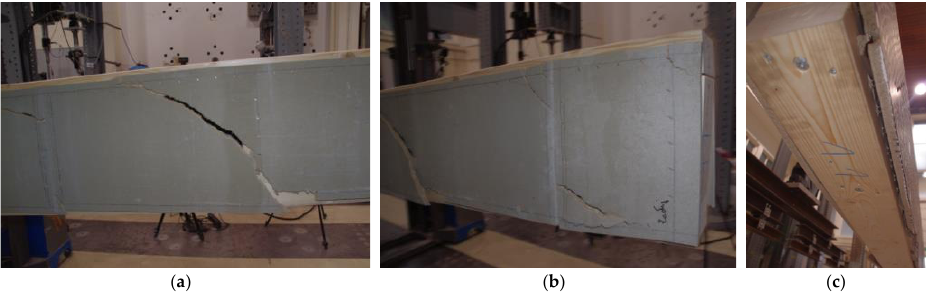
Figure 5. Damage mechanisms obtained for beams with cement-particle boards: ( a ) Tensile cracks of the cement-particle board and block shear failure of the board (right half of board); ( b ) Block shear and row shear failure of the boards in various locations; ( c ) Large deformations of the web – timber frame connections with more visible pull-out of the staples at beam ’ s end.